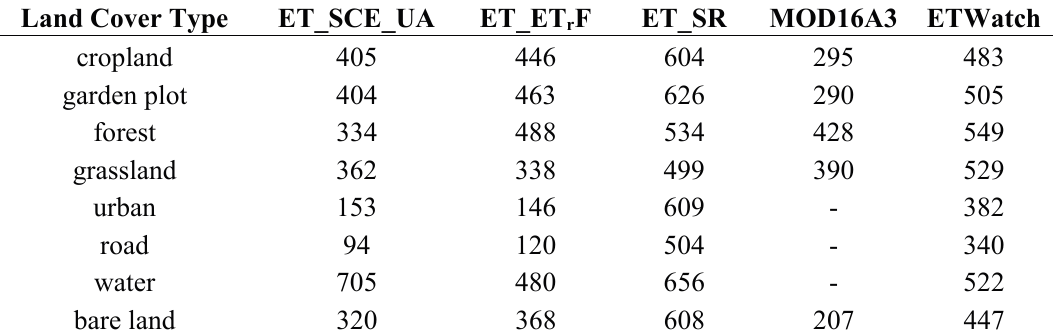
Figure 10. Annual ET distributions for the Beijing area in 2009. Table 7. Annual ET over different land covers in